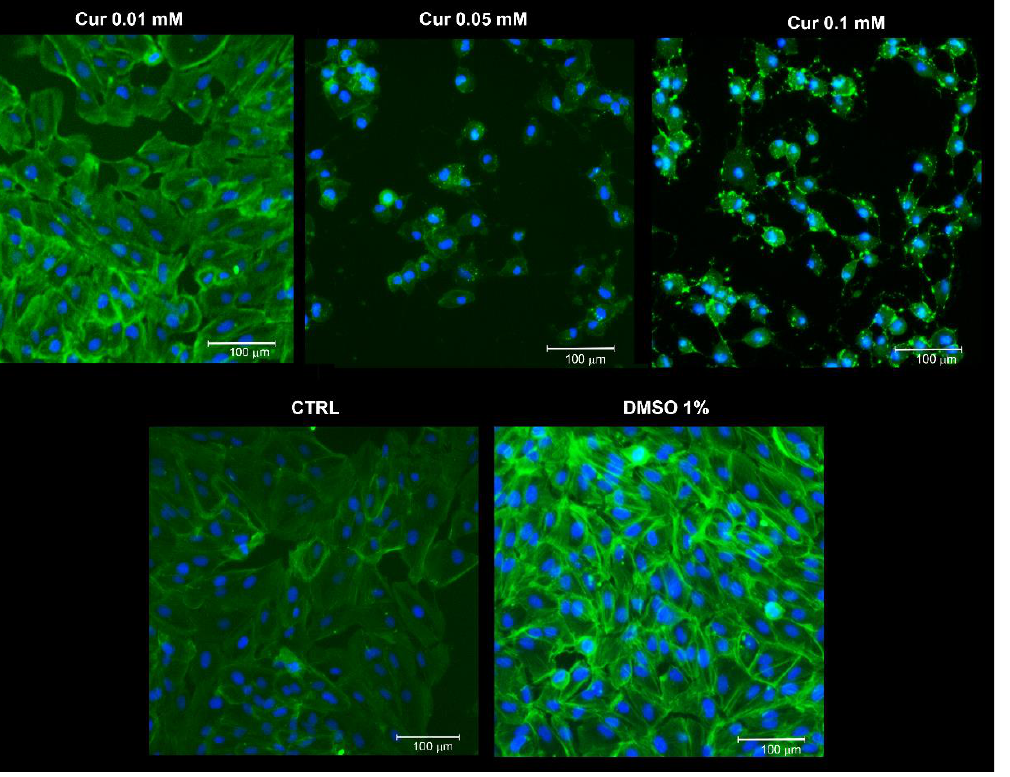
Figure 4. Morphological changes analysis. Representative images of ARPE-19 stained with phalloidin (green) and counterstained with the nuclear dye bisbenzimide (blue). Scale bar: 10 µ m. ARPE-19 cells undergo several morphological changes, including the exhibition of cellular protrusions from the cell body that are assimilable to a neuronal-like phenotype. The images of all the vehicles groups are reported in Figure S4.